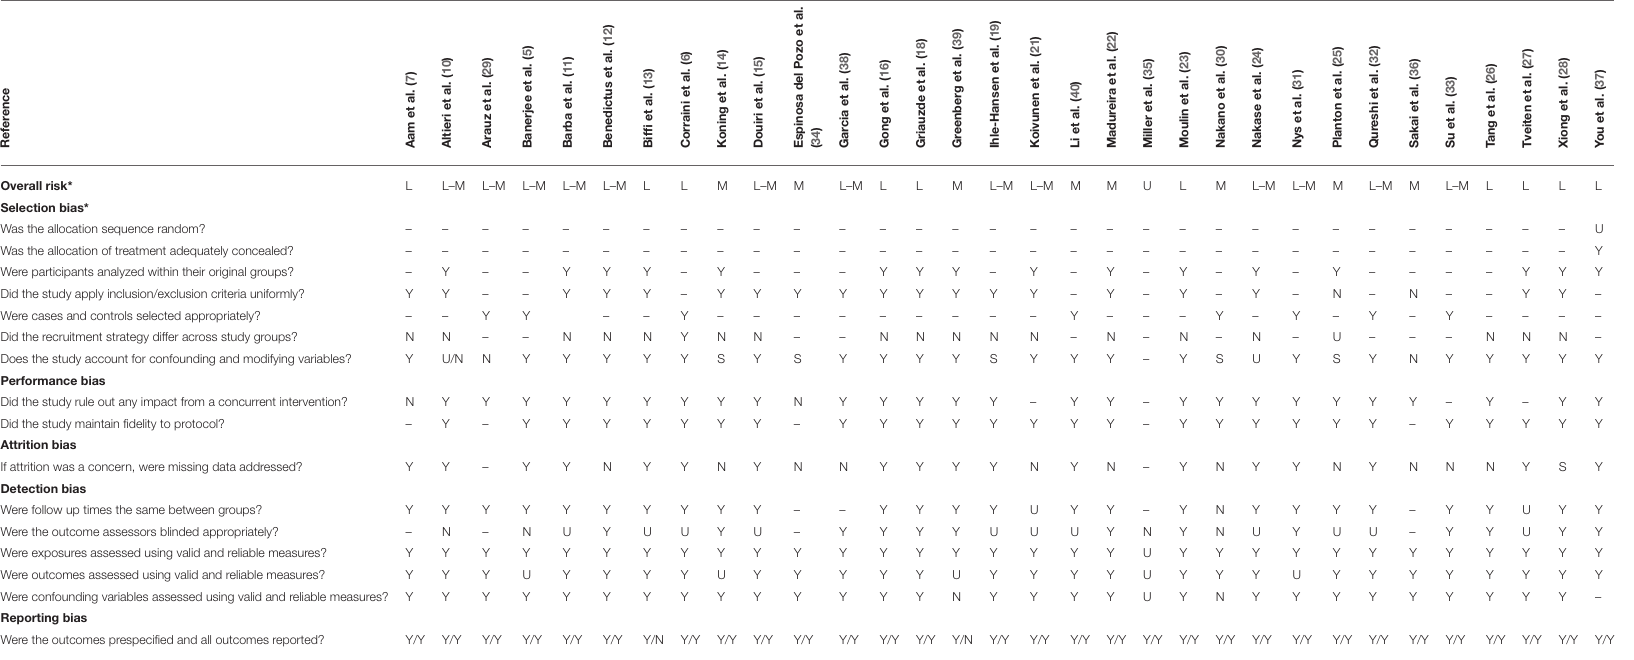
TABLE 4 | Assessment of risk for included studies, following AHRQ